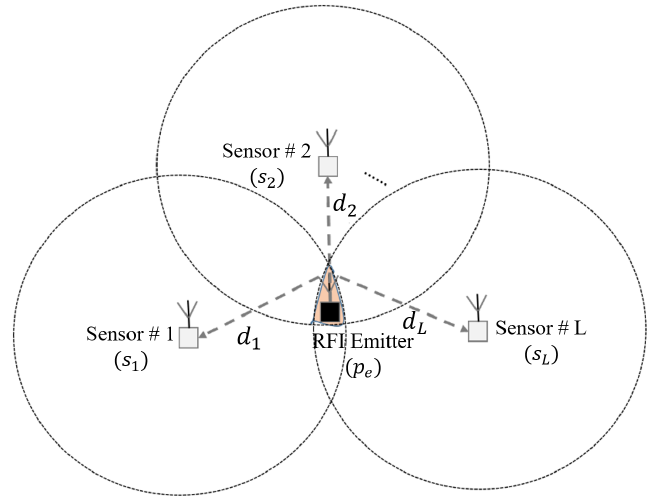
Figure 5. Time of arrival geolocation